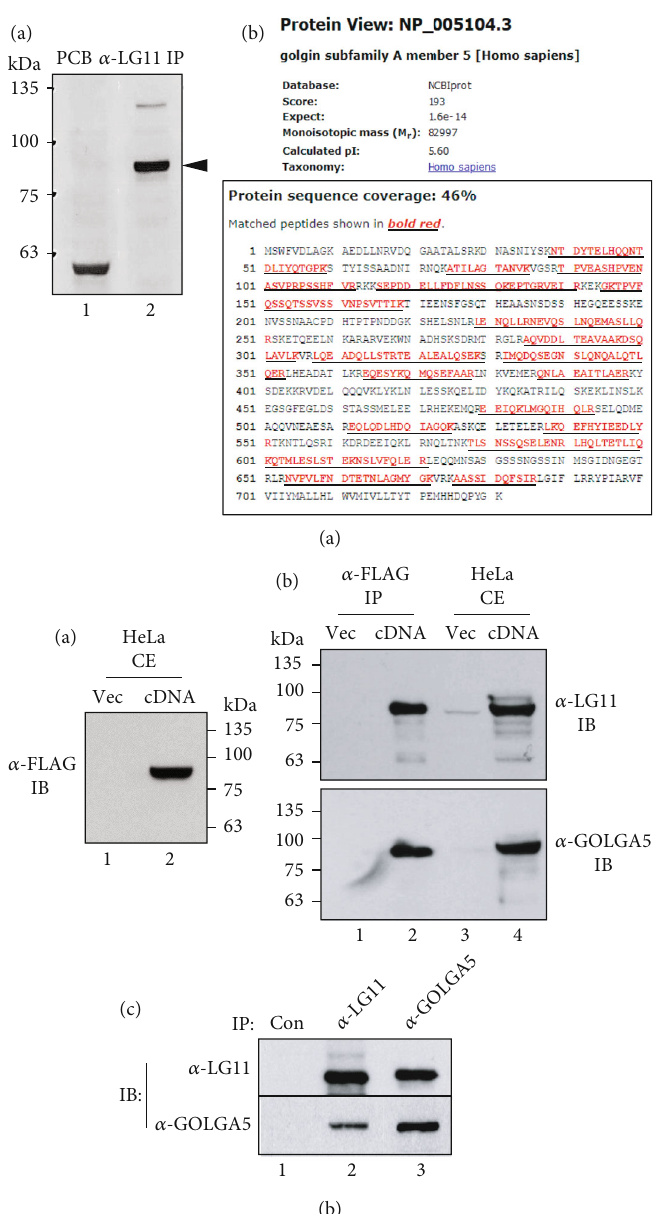
Figure 2: Identi fi cation of the antigenic molecule puri fi ed from the immunoprecipitates of anti-LG11 antibody. (a) The antigenic molecule recognized by anti-LG11 antibody. (A) Detection of the biotin-labeled LG11 antigenic molecule. Lane 1: preclearing without anti-LG11 antibody as control; lane 2: immunoprecipitates of anti-LG11 antibody. The antigenic molecule was indicated with arrowhead. (B) Identi fi cation of the antigenic molecule by mass spectrometric analysis. The tryptic peptides (underlines) were matched with GOLGA5 in protein sequence coverage of 46%. (b) Crossreactivity between anti-LG11 antibody and a commercial anti-GOLGA5 antibody in HeLa cells expressing GOLGA5 cDNA (A and B) and in TGF- β 1-induced PDL fi broblastic cells (C). Full length cDNA construct tagged by FLAG was expressed in HeLa cells and detected by anti-FLAG (A), anti-LG11, and anti-GOLGA5 antibodies (B). Anti-FLAG immunoprecipitates ( α -FLAG IP ) recognized by both anti-LG11 ( α -LG11 IB ) and anti-GOLGA5 ( α -GOLGA5 IB ) antibodies. The input amount of total cell extract was indicated as HeLa CE . Lanes 1 and 3: vector only; lanes 2 and 4: cDNA